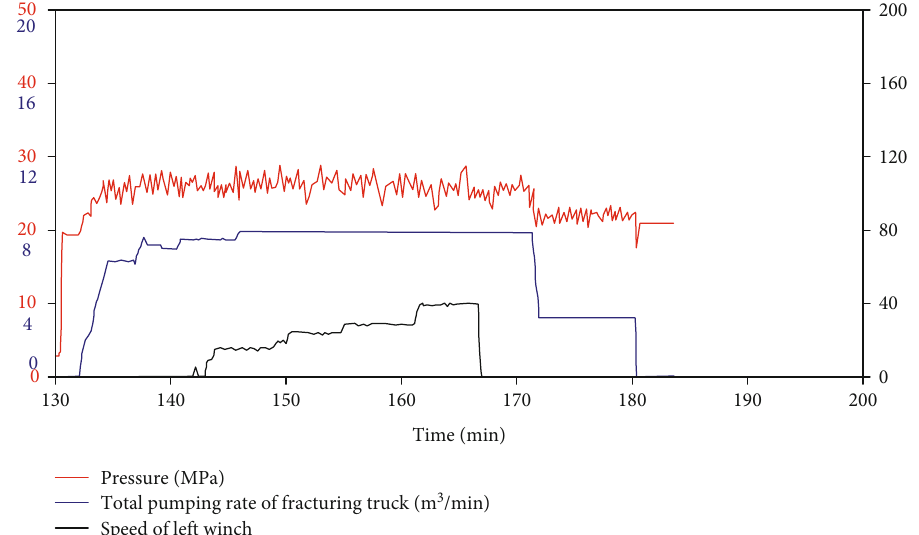
Figure 10: Curves of fracturing with the new thickener for Well Hong 87-X at pumping rates of 5 – 5.2m 3 /min.